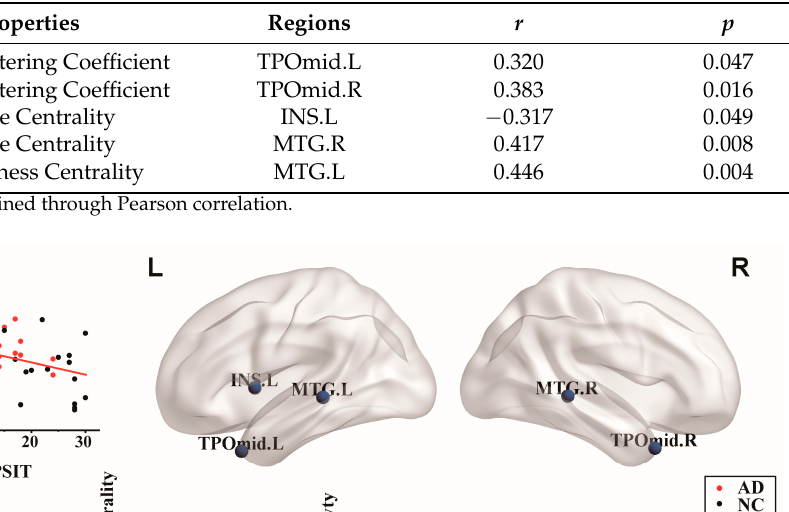
Table 3. UPSIT scores effects on nodal regions.